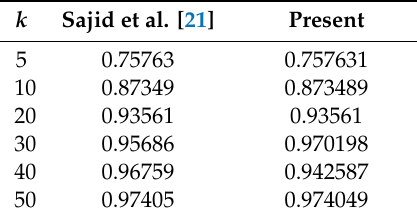
Table 1. Reliability of the Study.